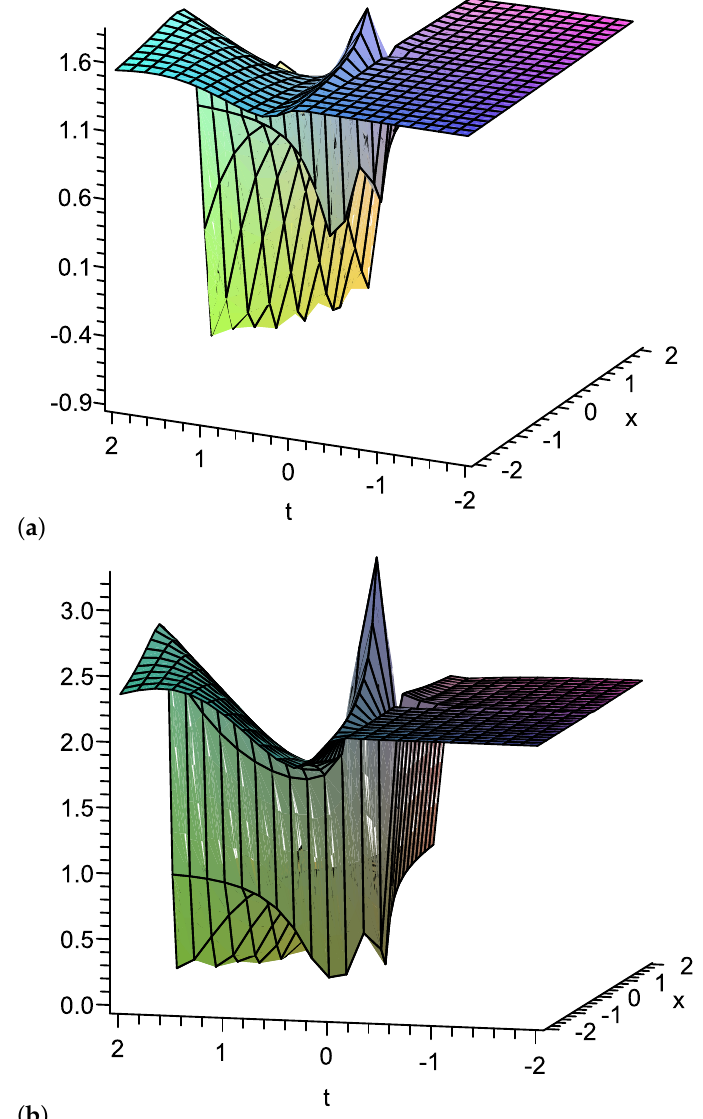
in (55); α is a beta distribution 3